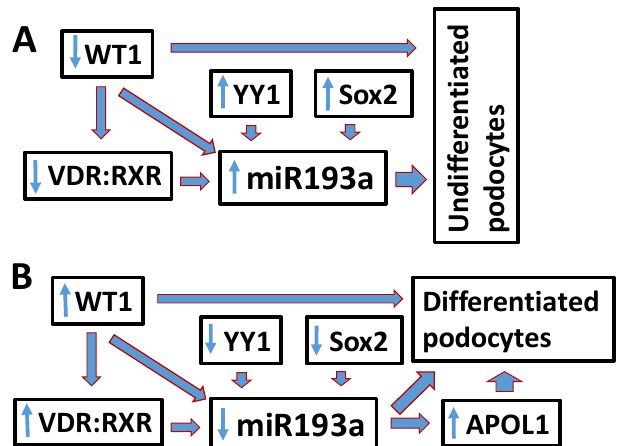
Figure 9. Schematic diagram showing modulation of miR193a expression determining the phenotype of podocytes. ( A ) Increased YY1/Sox2 expression enhances but own regulation of WT1 and VDR de-represses the expression of miR193a in UPDs. ( B ) Downing of YY1/Sox2 and escalation of WT1/VDR expression downregulates the expression of miR193a and maintains podocytes in a differentiated state.